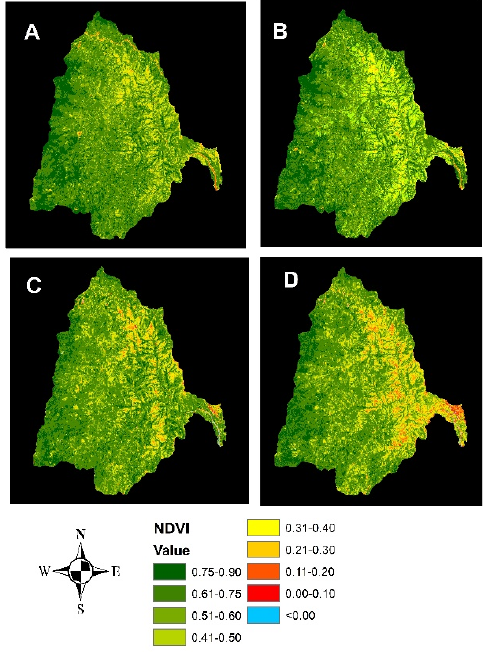
Figure 6. Changes in the NDVI values over time: 1986 ( A ), 1997 ( B ), 2009 ( C ), and 2015 ( D ). For each year, the dry season NDVI was represented.